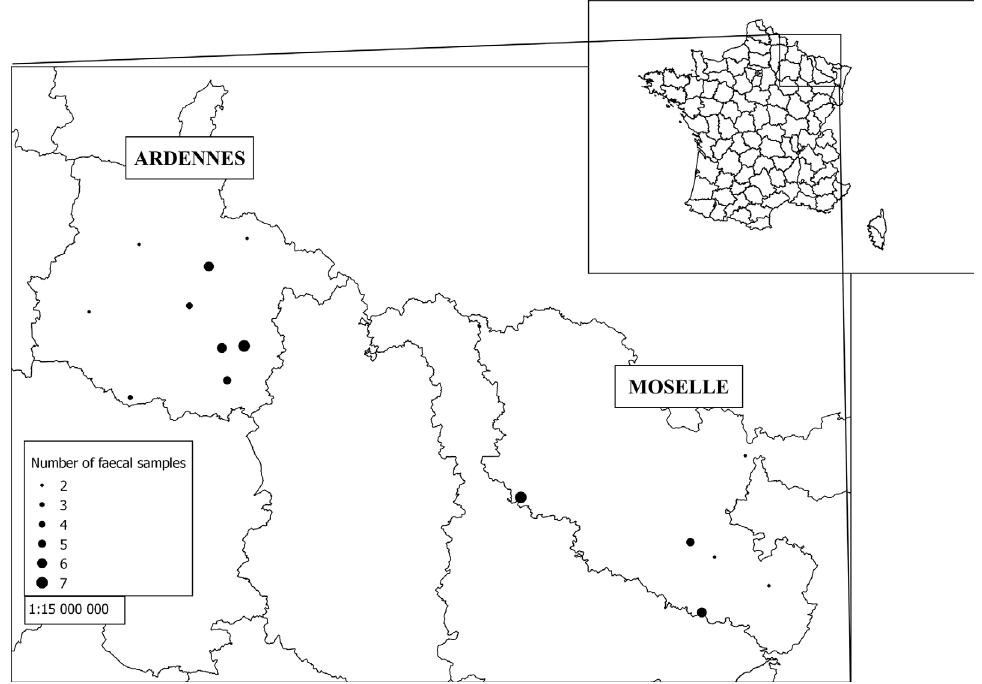
Figure 1. Geographical distribution of the collected feces. For each fecal sample, one soil sample was collected under the fecal sample and another one between 50 cm and 1 m from the first